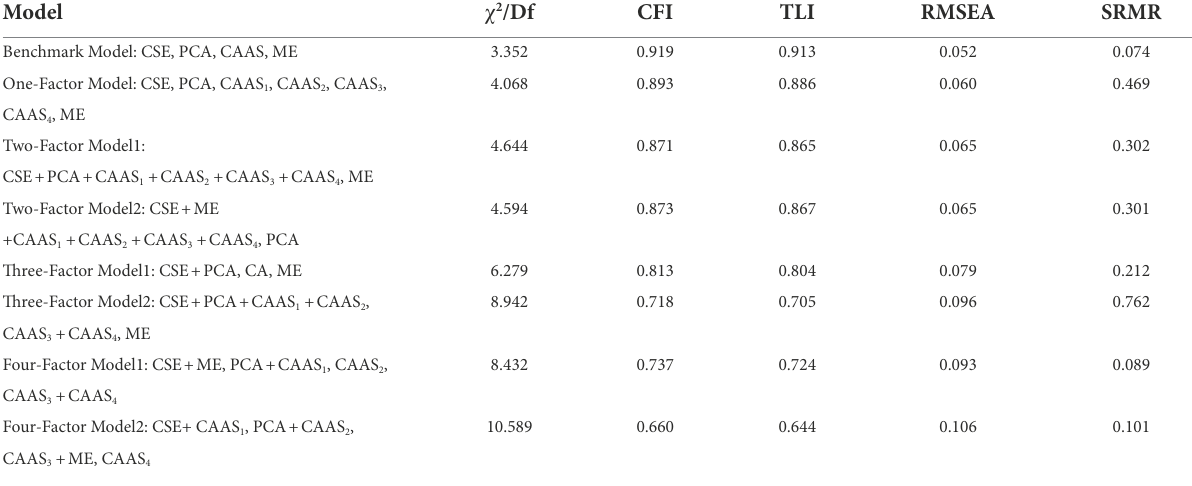
TABLE 1 Results of confirmatory factor